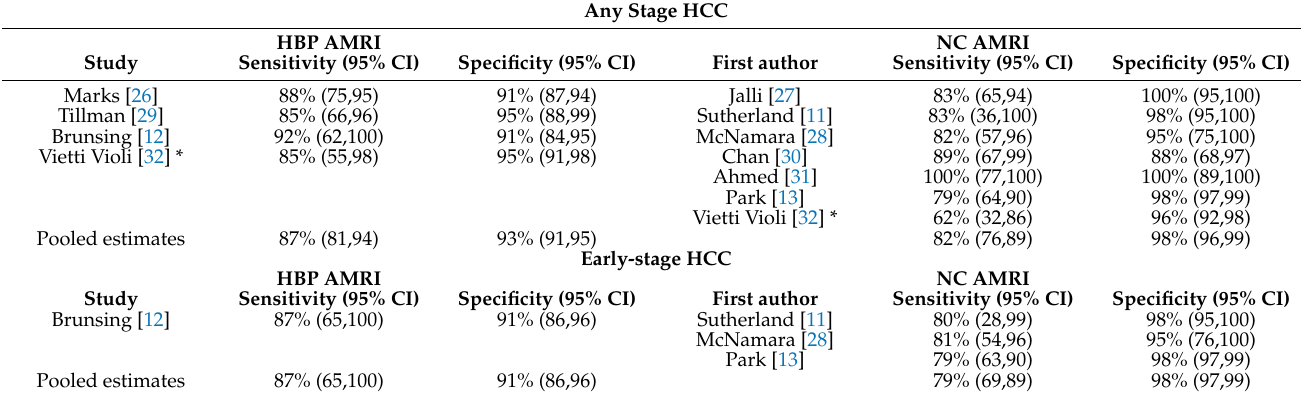
Table 2. Diagnostic performance of AMRI for detecting hepatocellular